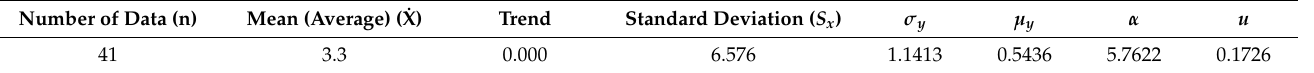
Table 3. Results of the parameters of the Gumbel method equation. Where α and u are parameters of the expression and σ y and µ y are values that are based on the number of data or total samples, which are given based on S á nchez [37].